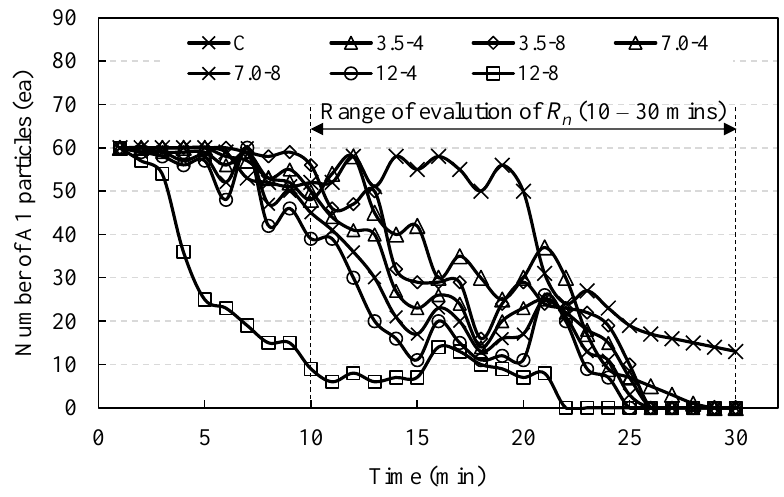
Figure 7. Number of A1 particles with respect to time.